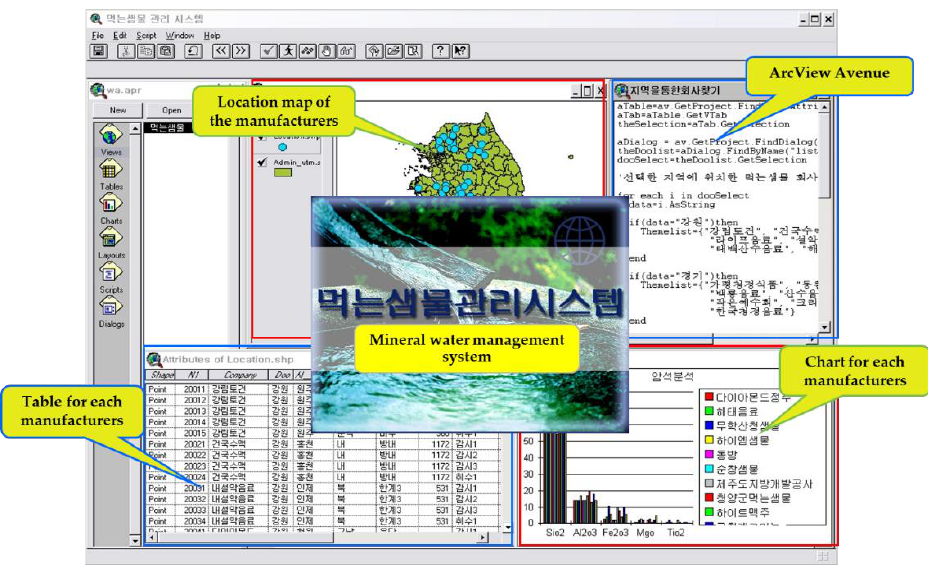
Figure 2. The initial screen of the mineral water management system.